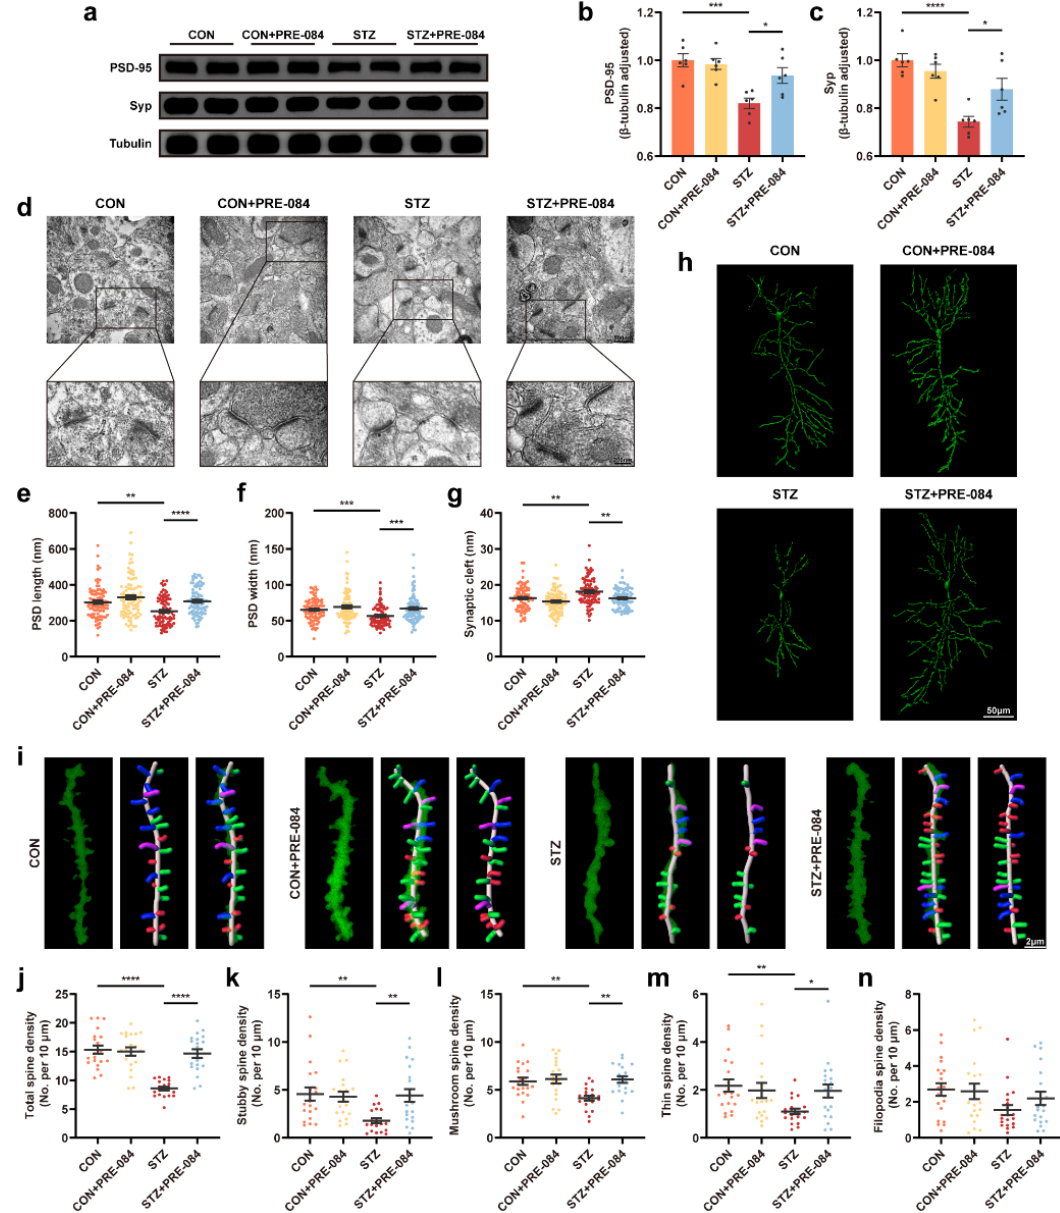
Figure 3. The effect of Sig-1R agonist on synapse change in the hippocampus of mice with T1DM. ( a – c ) Representative Western blots and quantitation of PSD-95 and Syp protein expression in CON, CON + PRE-084, STZ, and STZ + PRE-084 mice ( n = 6). ( d – g ) Representative images of synaptic ultrastructure ( d ), quantitative analysis of PSD length ( e ) and width ( f ), and synaptic cleft ( g ) ( n = 85–90; 3 animals per group). The scale bars are 500 and 200 nm. ( h ) Golgi staining images of the neuronal morphology. The scale bar is 50 µ m. ( i ) Representative three-dimensional reconstruction images of different types of the spine in hippocampal neurons, including stubby (red), mushroom (green), thin (blue), and filopodia (purple) spines. The scale bar is 2 µ m. ( j – n ) Quantitation of density of different spines, including total ( j ), stubby ( k ), mushroom ( l ), thin ( m ), and filopodia ( n ) spines ( n = 20; 3 mice per group). The data were presented as mean ± SEM and analyzed via one-way ANOVA with Tukey’s multiple comparison tests, Welch’s ANOVA test followed by Dunnett’s T3 multiple comparison tests, and Kruskal-Wallis test followed by Dunn’s multiple comparison tests. * p < 0.05; ** p < 0.01; *** p < 0.001; **** p < 0.0001. Sig-1R, sigma-1 receptor; T1DM, type 1 diabetes mellitus; PSD, postsynaptic density; Syp, synaptophysin; CON, control mice; STZ, mice with